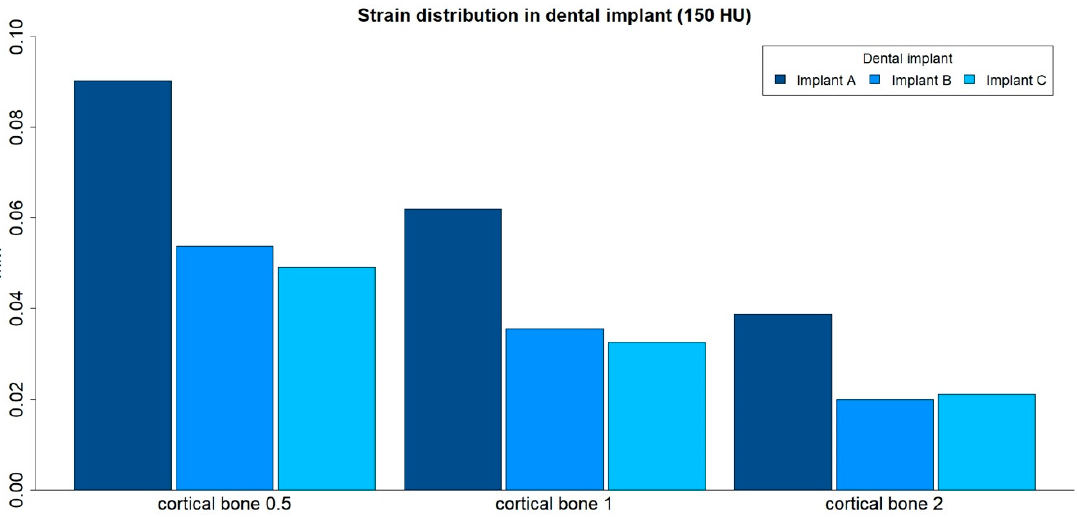
Figure 6. Strain distribution (mm) in implants, in low-density medullar bone (150 HU), for all cortical thicknesses (0.5 mm, 1 mm, and 2 mm) in all implant designs: A, B, and C.